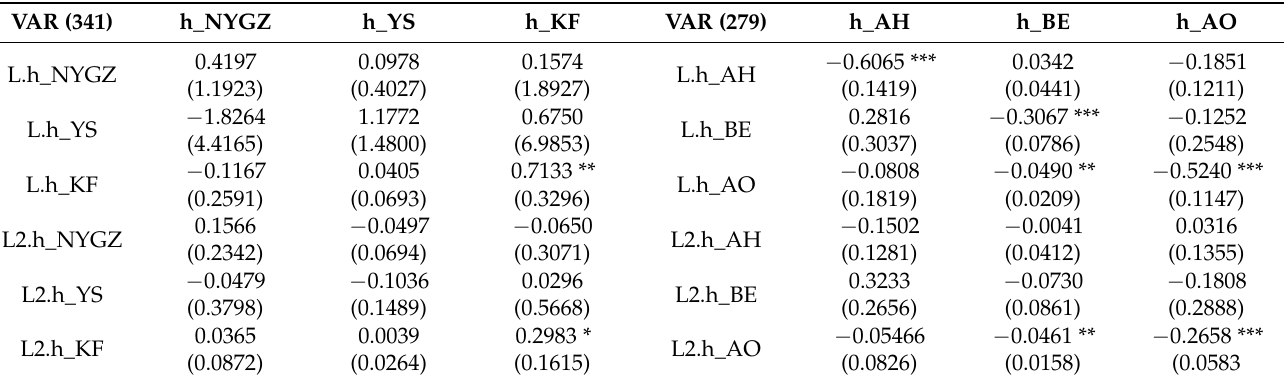
Table 8. GMM estimation results of PVAR model (lag 2).